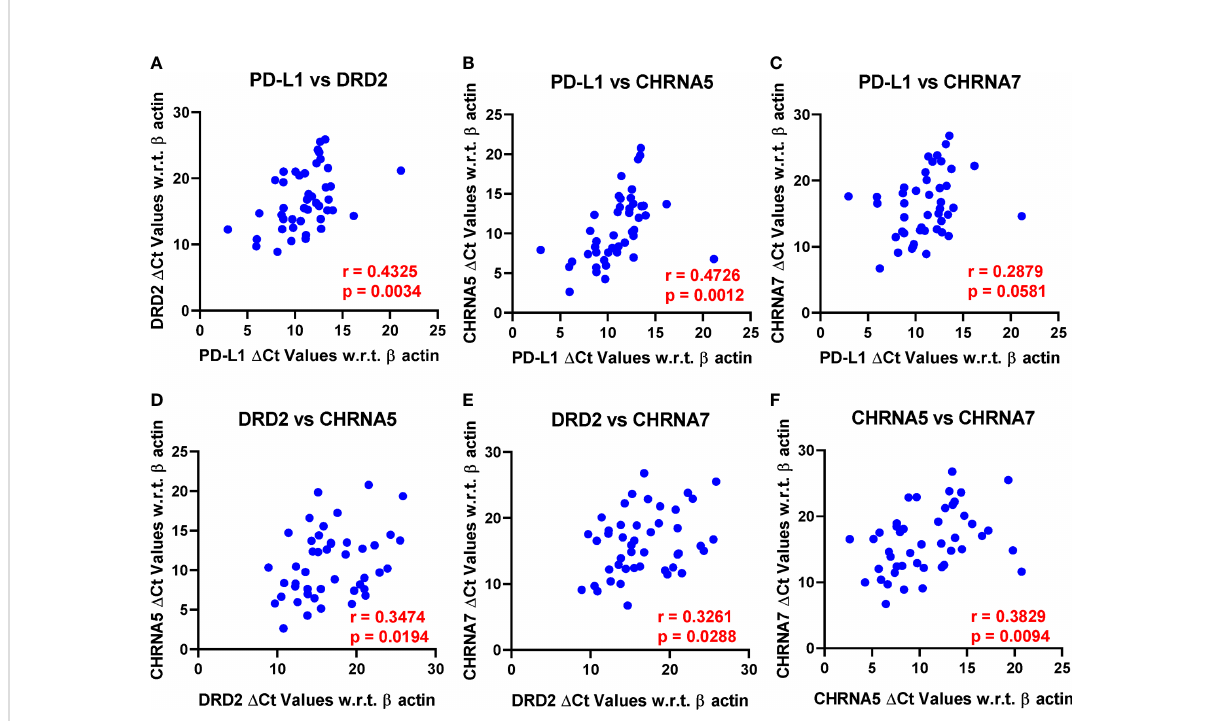
FIGURE 2 Pearson ’ s correlation analysis was performed to analyze the correlation between PD-L1, DRD2, CHRNA5, CHRNA7, and CHRNA9 mRNA expression represented as D Ct values. Only those reaching or close to reaching statistical signi fi cance were included. r, Pearson ’ s correlation coef fi cient. (A) PD-L1 vs DRD2, (B) PD-L1 vs CHRNA5, (C) PD-L1 vs CHRNA7, (D) DRD2 vs CHRNA5, (E) DRD2 vs CHRNA7, and (F) CHRNA5 vs